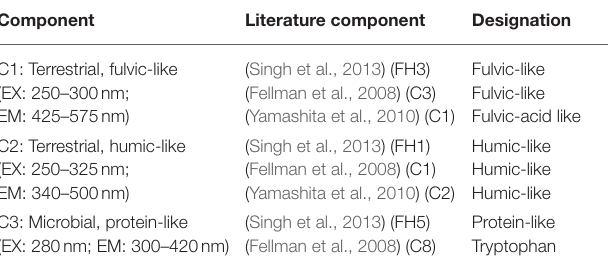
TABLE 1 | Comparison of our validated PARAFAC components with published models.